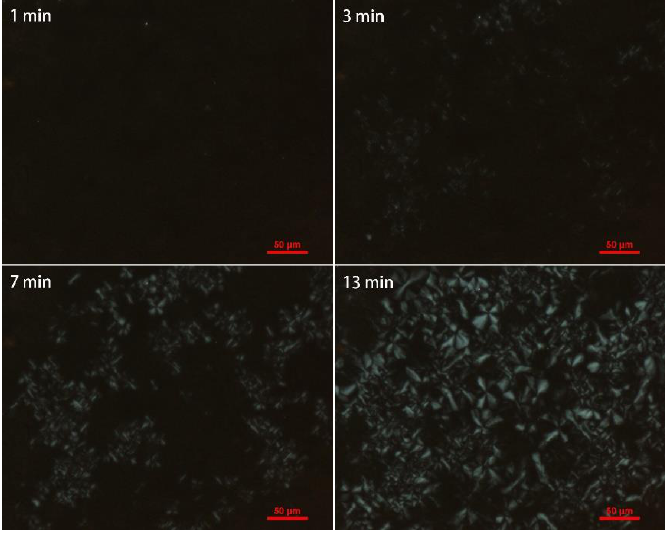
Figure 12. Polarizing optical micrograph of iPB-g-MAH (Gd = 1.563%) at 85 °C with changing time.